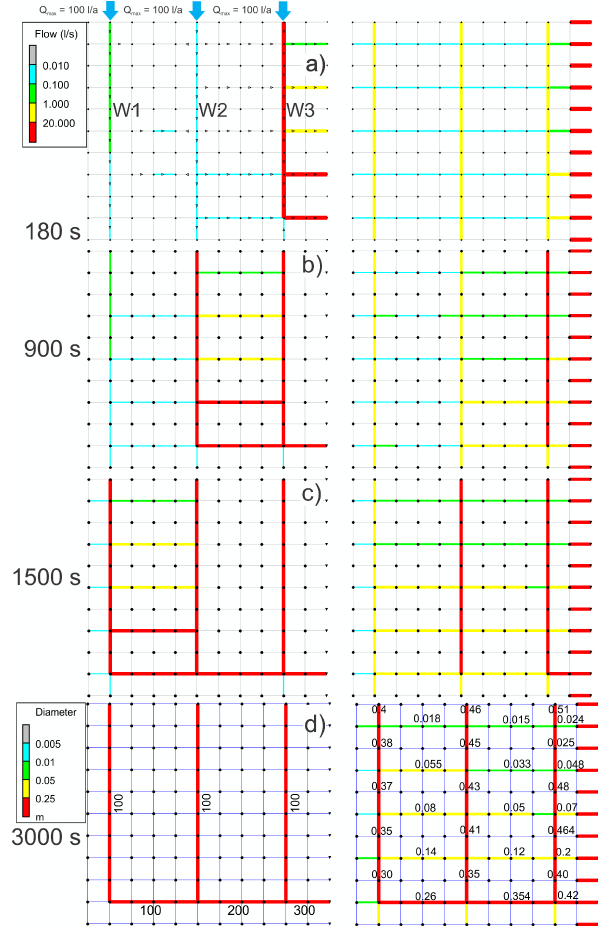
Figure 19. High-dip network with three prominent conduits (wells), marked by W1 to W3. A recharge of 100Ls − 1 is available to the prominent